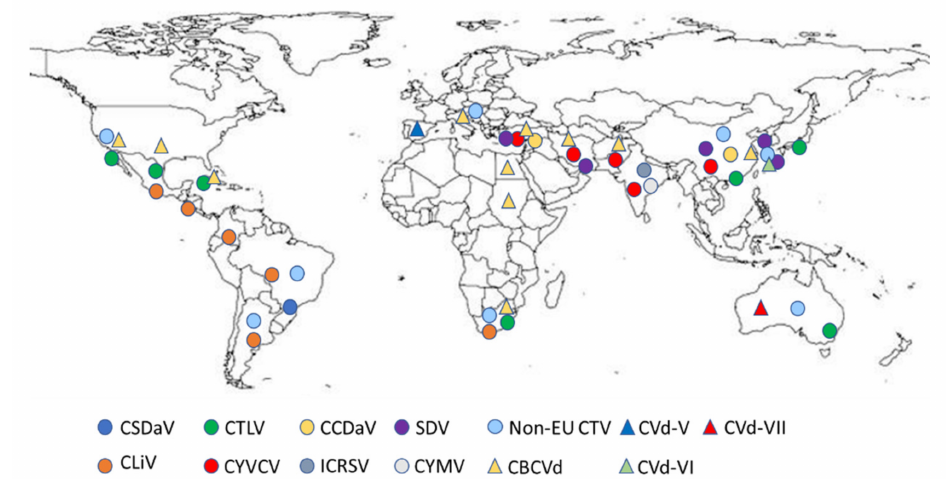
Figure 1. Global distribution map of exotic citrus viruses and viroids relevant to the Mediterranean region (extracted from EPPO Global database 2021, accessed in July 2021). CSDaV, Citrus sudden death-associated virus; CTLV, Citrus tatter leaf virus; CCDaV, Citrus chlorotic dwarf-associated virus; SDV, Satsuma dwarfing virus; Non-EU CTV, stem pitting and resistance breaking citrus tristeza virus; CLiV, Citrus leprosis virus (sensu lato); CYVCV, Citrus yellow vein clearing virus; ICRSV, Indian citrus ringspot virus; CYMV, Citrus mosaic virus; CBCVd, Citrus bark cracking viroid; CVd-V, Citrus viroid V; CVd-VI, Citrus viroid VI; CVd-VII, Citrus viroid